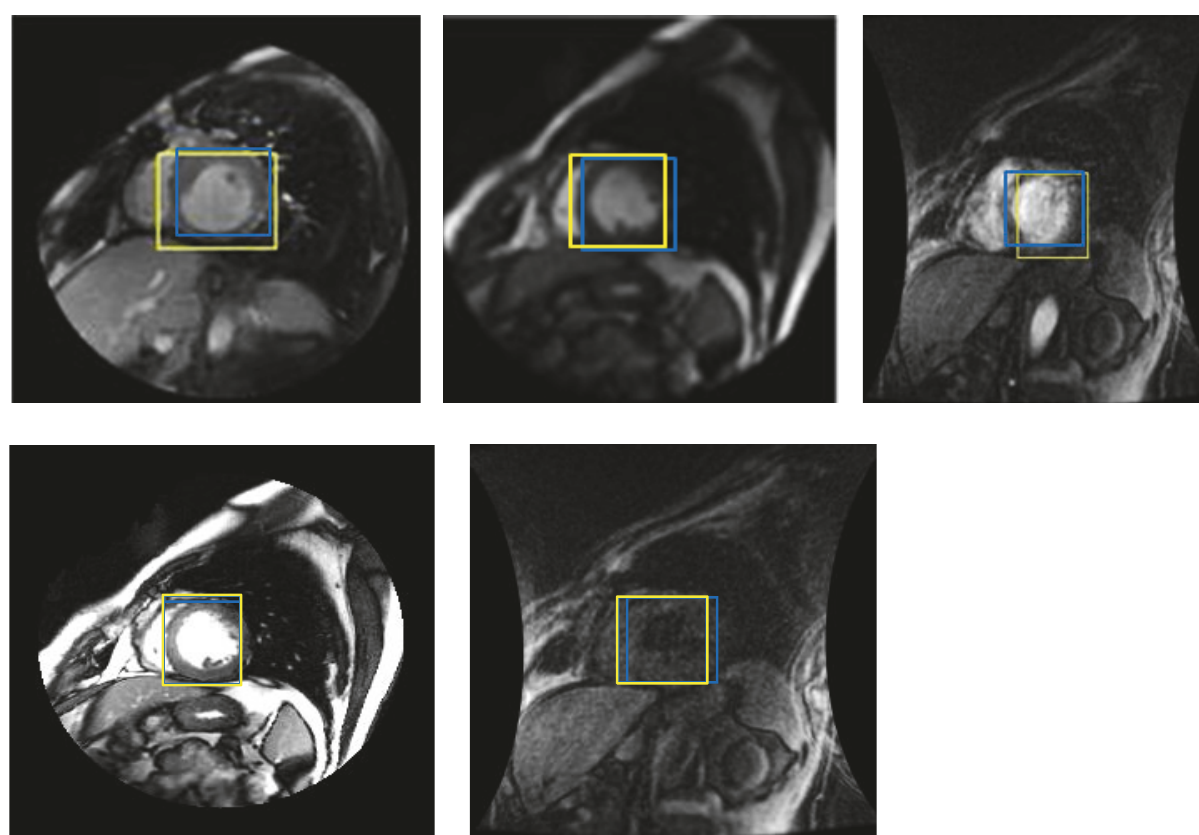
Figure 11: Manual and network detection results. Yellow color: network’s detection; blue color: expert’s manual